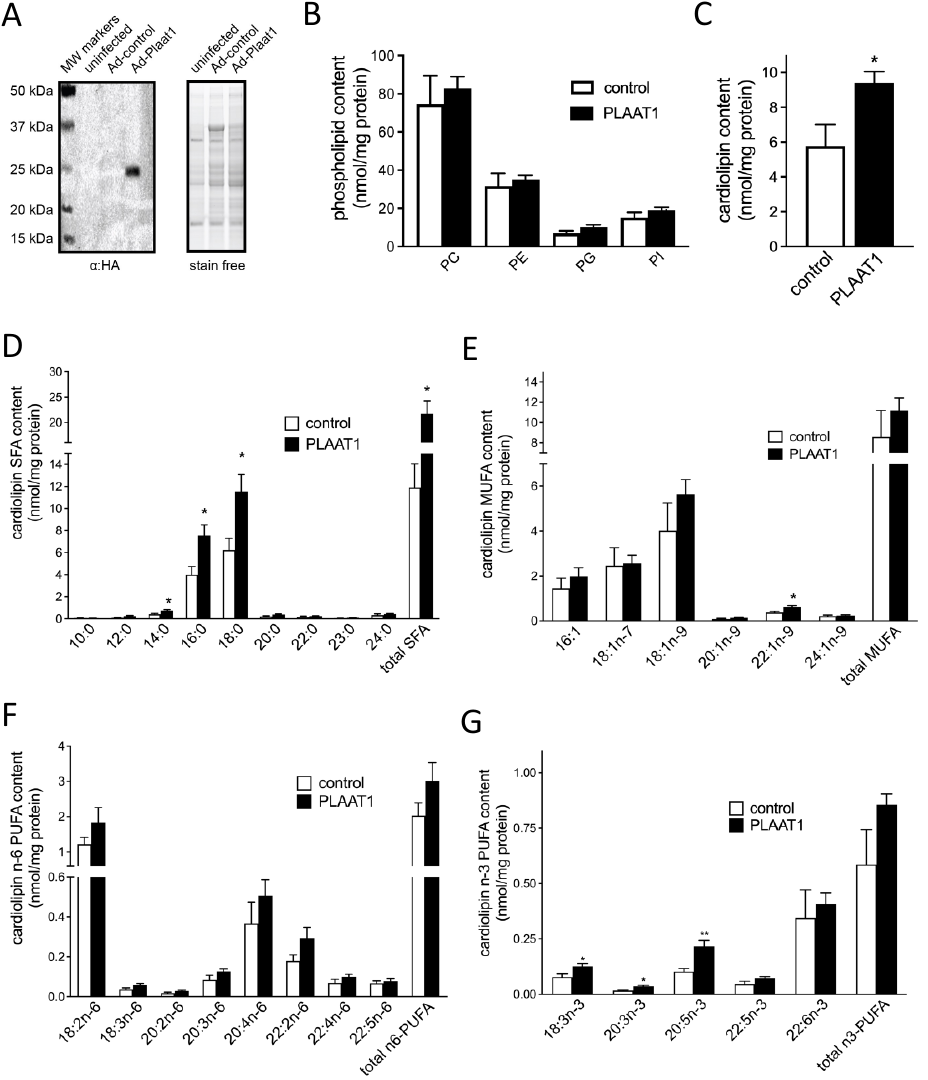
Figure 2. PLAAT1 expression in HEK-293 cells increases cardiolipin content. A representative immunoblot of HA-tagged PLAAT1 in HEK-293 cells is shown (left panel) with total protein loading imaged under UV light using a stain-free gel (right panel) ( A ). In HEK-293 cells expressing PLAAT1, or in control cells, the contents of major phospholipid species ( B ) and cardiolipin ( C ) were determined using gas chromatography. Analysis of the fatty acyl composition of cardiolipin is reported as individual and total saturated fatty acids (SFAs) ( D ), monounsaturated fatty acids (MUFAs) ( E ), n-6 polyunsaturated fatty acids (PUFAs) ( F ), and n-3 PUFAs ( G ). Data are means ± S.E.M. ( n = 8–9). * p < 0.05, ** p <